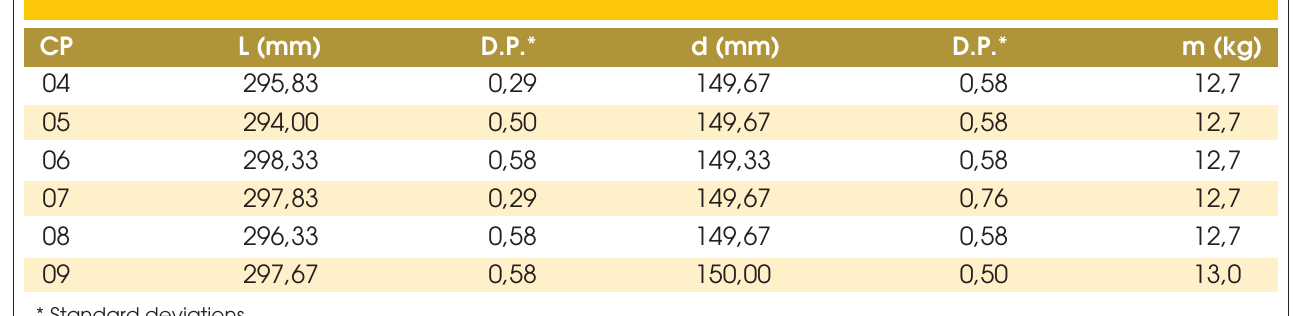
Table 2 – Geometrical parameters and mass of the cylindrical